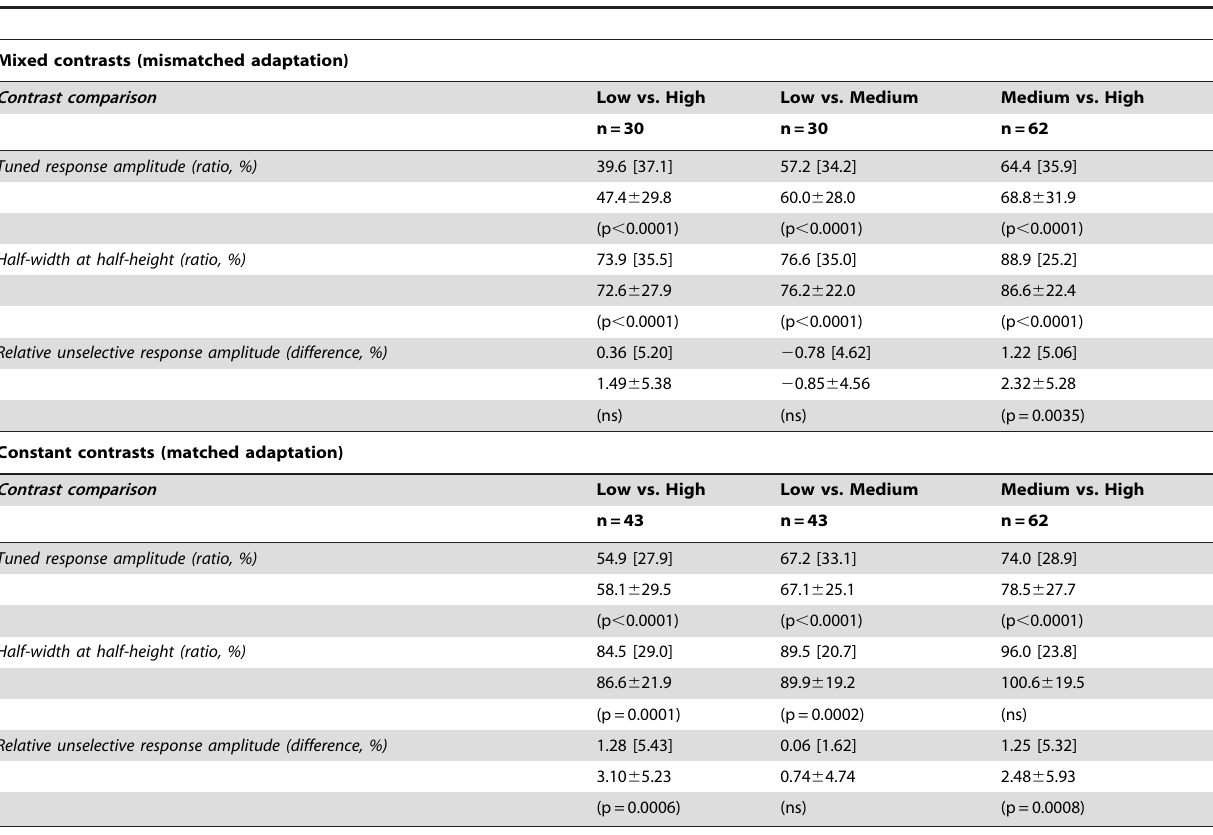
Table 2. Paired comparison and associated ratios for tuned response amplitude and half-width at half-height, and differences for relative untuned response amplitude, at different contrasts and with matched or mismatched adaptation.